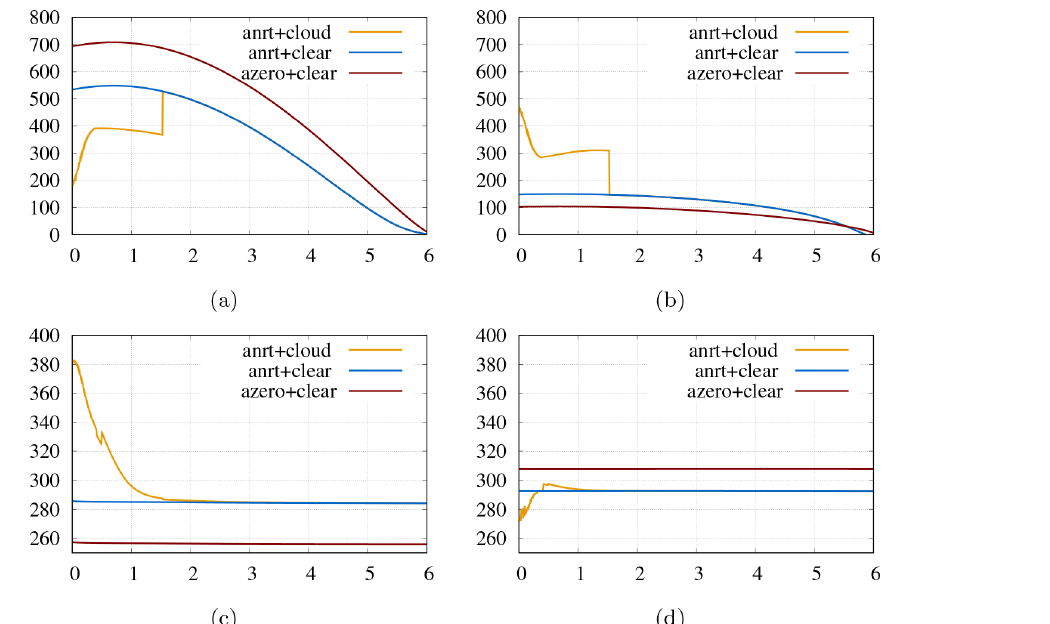
Figure 1. Evolution of radiative fluxes ( y -axis, Wm − 2 ) as a function of time ( x -axis, h) in a MUSC experiment over Badajoz in Spain done using the HLRADIA radiation scheme. No aerosols or clouds (red), aerosols (blue), aerosols and clouds (yellow). (a) Downward SW radiation at the surface (SWDS), (b) upward SW radiation at the TOA (SWUT), (c) downward LW radiation at the surface (LWDS), (d) upward LW radiation at the TOA (LWUT). The downward SW radiation at the TOA at Badajoz (38.9 ◦ N, 7 ◦ W) was 895Wm − 2 at 12:00UTC on 22 February 2017, when the experiments were started under the given atmospheric conditions and aerosol